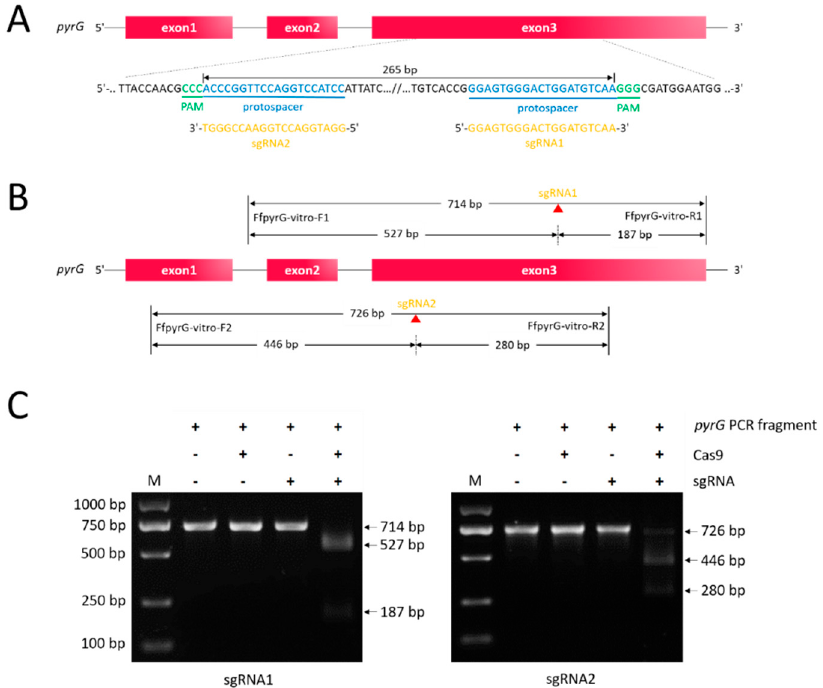
Figure 1. Schematic illustration of sequence information and in vitro Cas9 cleavage assay. ( A ) Sequences of the two sgRNAs targeting pyrG are shown in yellow font, both of which were located at exon3. Sequence directions are all 5 ′ –3 ′ as shown. Schematic representation of exons was not drawn to scale. ( B ) Fragments required for in vitro Cas9 cleavage assay were amplified with primer pairs FfpyrG-vitro-F1/FfpyrG-vitro-R1 and FfpyrG-vitro-F2/FfpyrG-vitro-R2, respectively. Target regions that could be recognized by sgRNA1 or sgRNA2 were cleaved by Cas9 (red triangles), yielding two small fragments. ( C ) Visualization of the in vitro Cas9 cleavage assay through agarose gel electrophoresis. M,